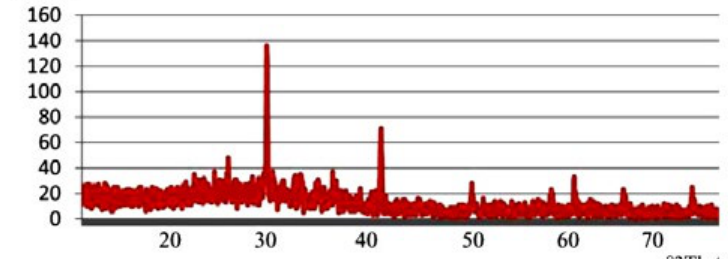
O magnetic nanoparticles 3 4